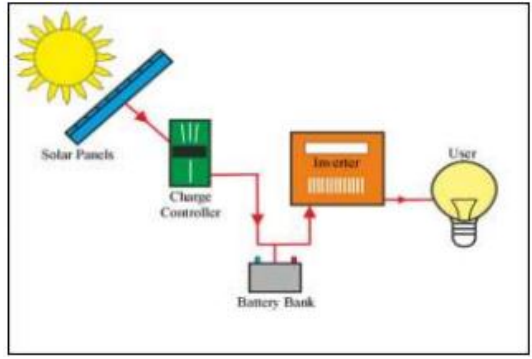
Figure 2. The schematic of (PV) system for